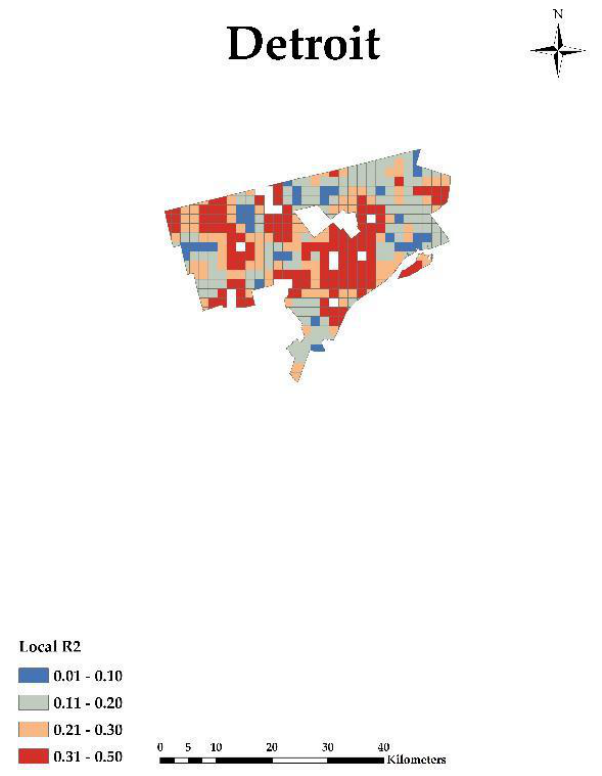
Figure 18. Detroit shrinking city: GWR Local r-squared.